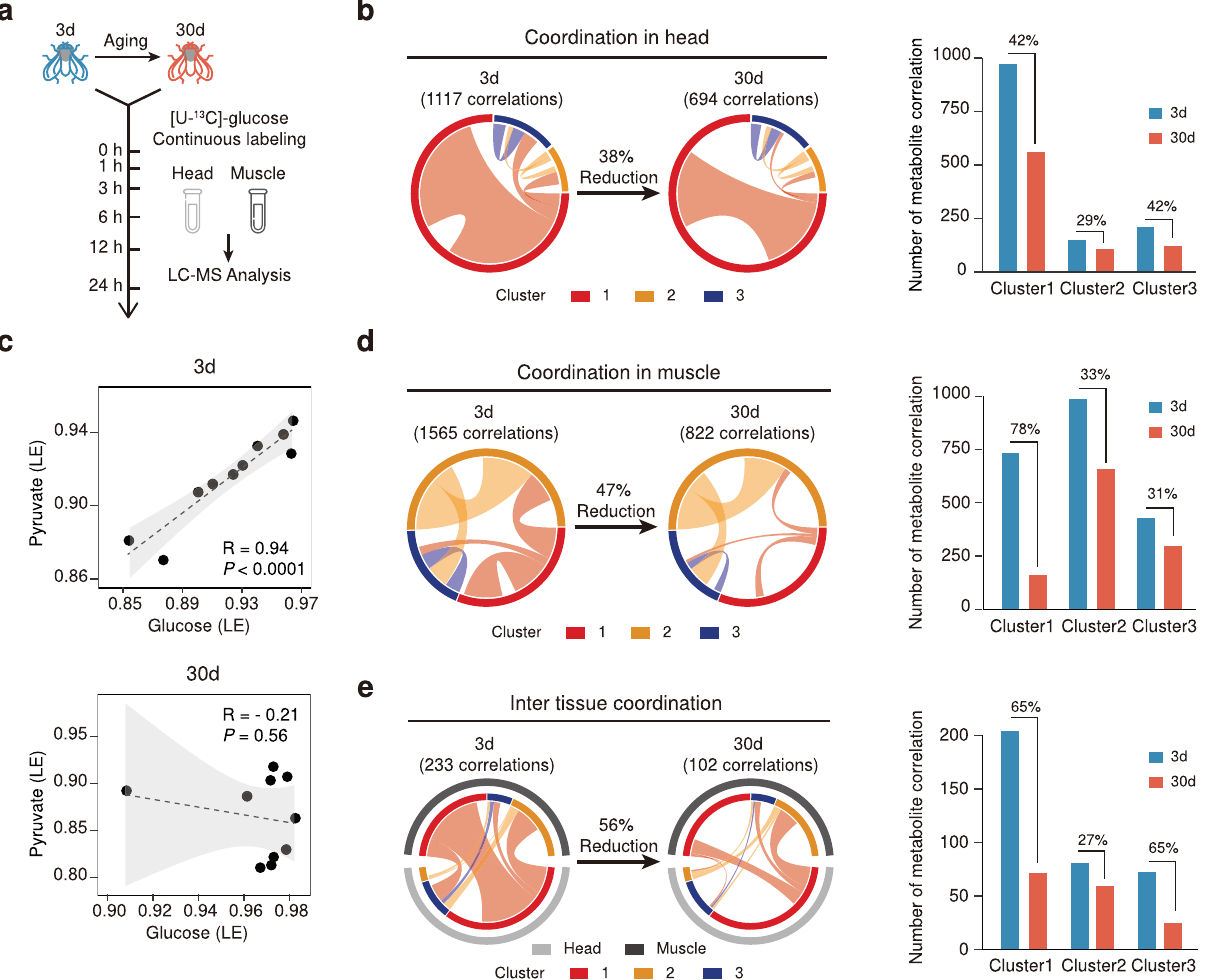
Fig. 4 System-wide alternations of metabolic homeostasis in Drosophila during aging. a The in vivo isotope tracing metabolomics of young (3d) and old (30d) Drosophila . b Left, a Circos plot showing metabolite – metabolite correlations in young and old Drosophila head tissues. Right, a bar plot showing the numbers of metabolite – metabolite correlations in each metabolite cluster. c Correlation of labeling extents for the labeled glucose and pyruvate during aging ( n = 10 biological replitates in each group). Dashed line, linear regression; gray shadow, 95% con fi dence interval of the linear relationship between pyruvate and glucose. The p -value of Pearson correlation coef fi cient was calculated by two-sided Student ’ s t -test. d Left, a Circos plot showing metabolite – metabolite correlations in young and old Drosophila muscle tissues. Right, a bar plot showing the numbers of metabolite – metabolite correlations in each metabolite cluster. e Left, a Circos plot showing metabolite – metabolite correlations between head and muscle tissues in young and old Drosophila . Right, a bar plot showing the numbers of metabolite – metabolite correlations in each metabolite cluster. In panels b , d , e , the colored circle refers to the labeling rate cluster. Clusters 1 – 3 represent the labeling rate clusters in Figs. 2 and 3. Ribbon connecting metabolite clusters refers to the signi fi cant correlations between metabolites. Ribbon thickness refers to the number of signi fi cant metabolite-to-metabolite correlations. Source data are provided as a Source Data fi